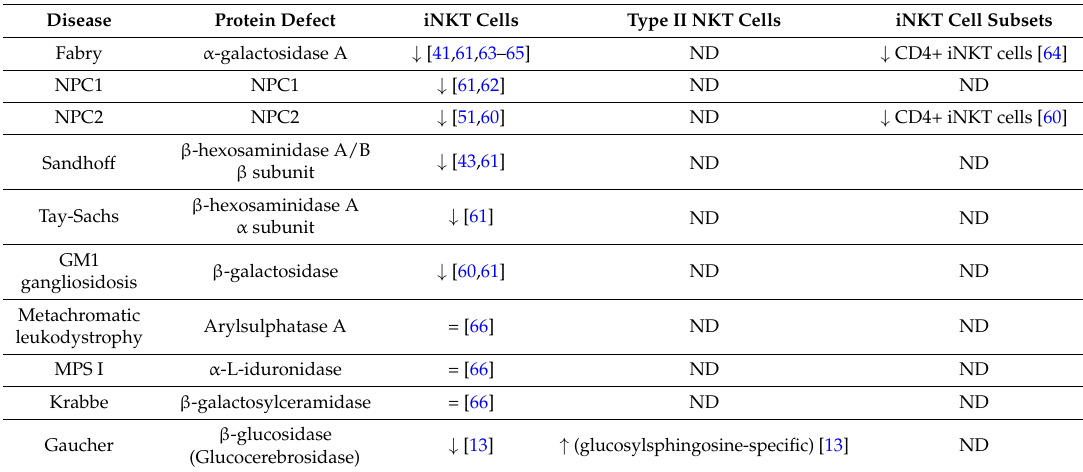
Table 2. NKT cells in Lysosomal Storage Diseases mouse models.